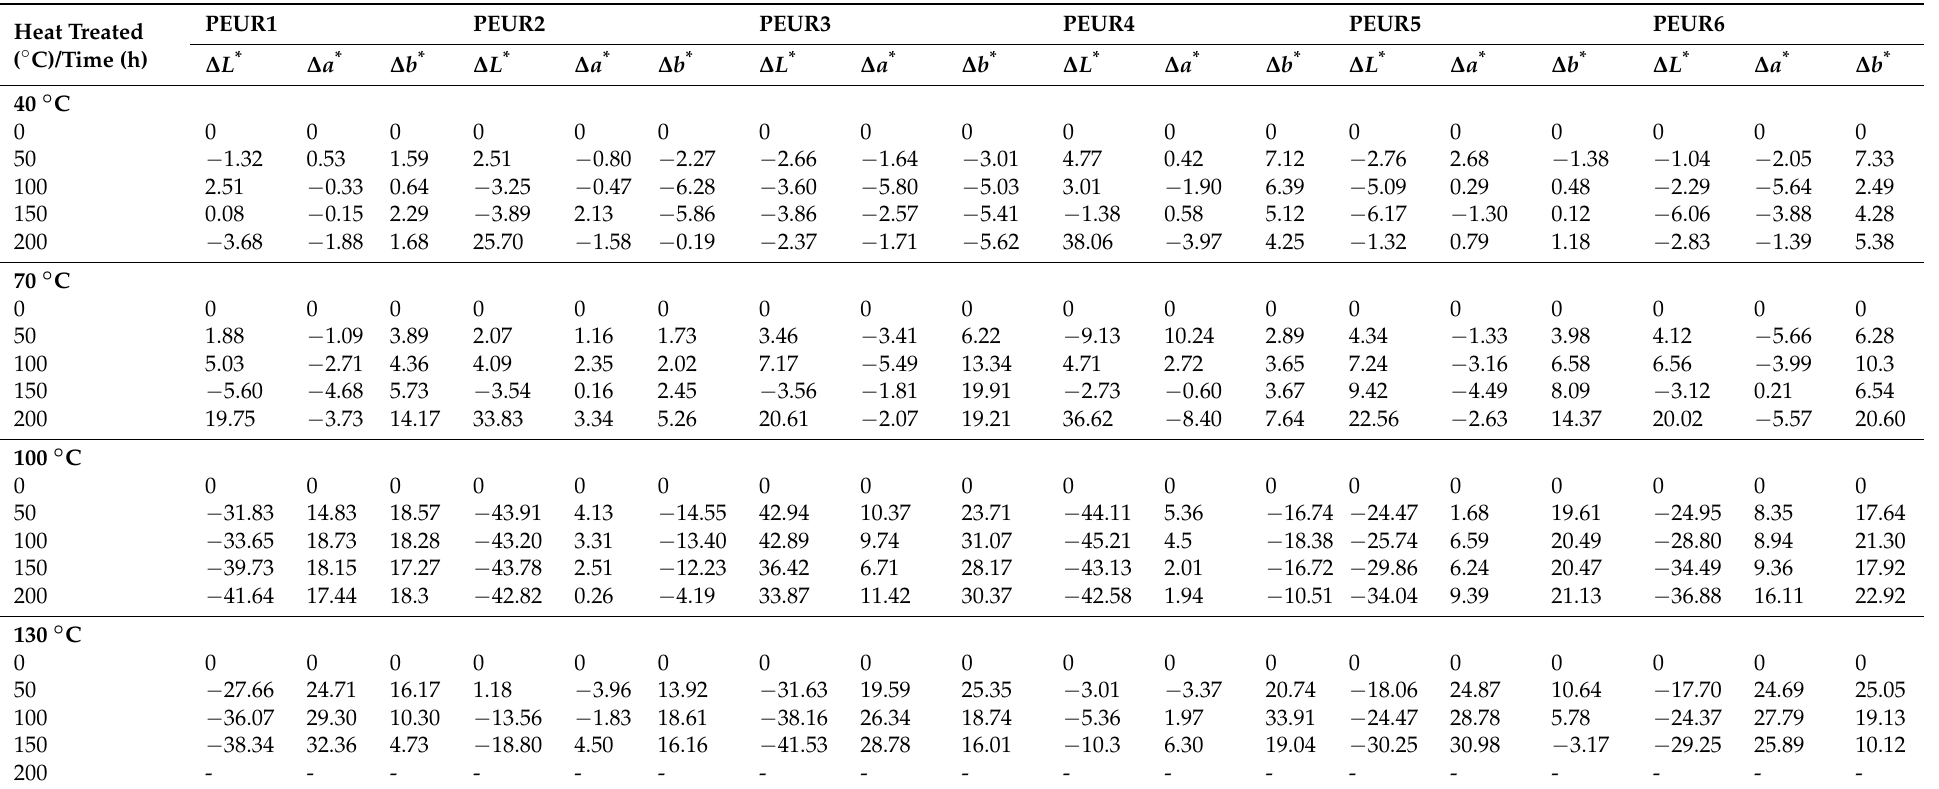
Table 2. Color parameters variation during thermal